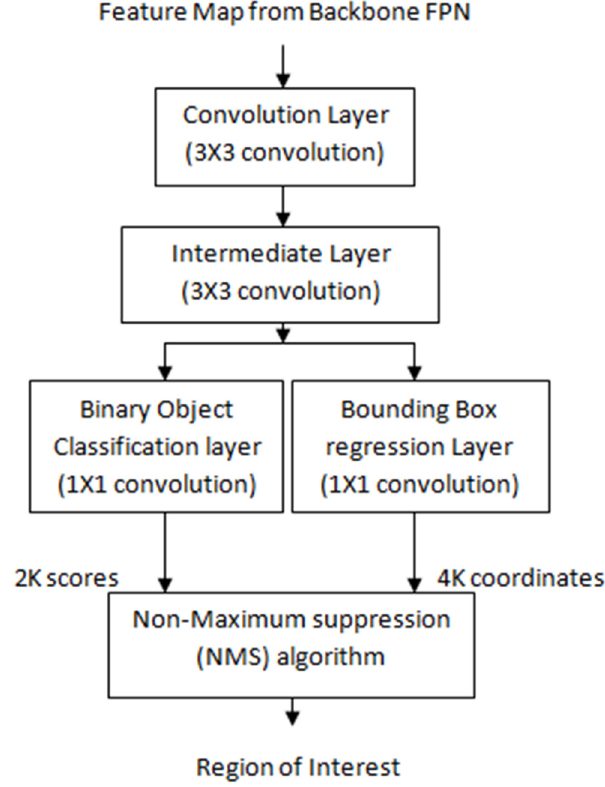
Figure 5. Regional Proposal Network.